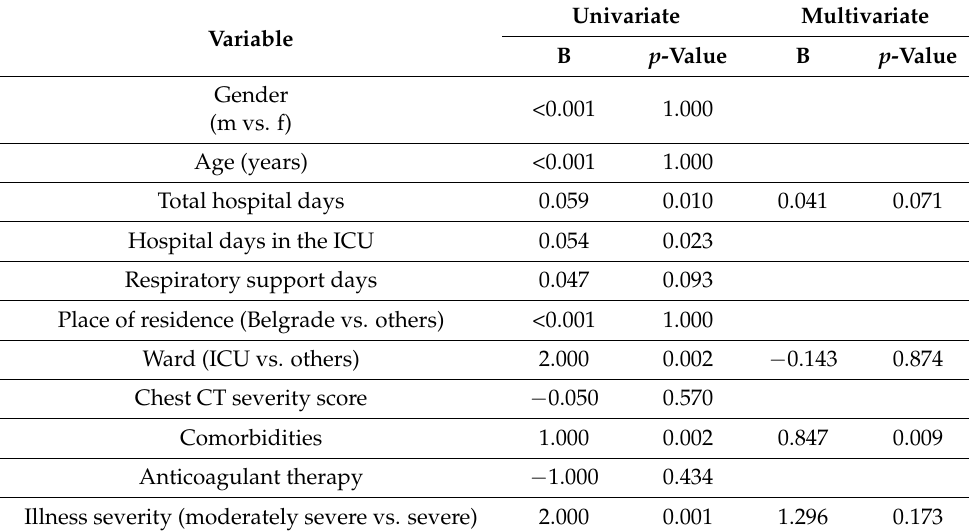
Table 2. Quantile regression with the number of RBC doses as a dependent variable, N = 90. Variable